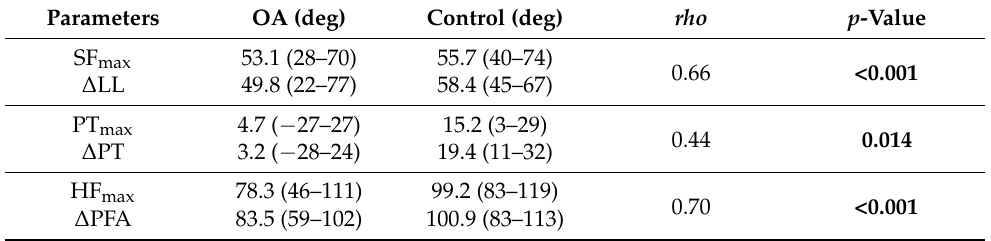
Table 3. Summary of participants’ radiography and motion capture analysis assessments, correlation coefficients ( r ), and correlation significance, reporting mean